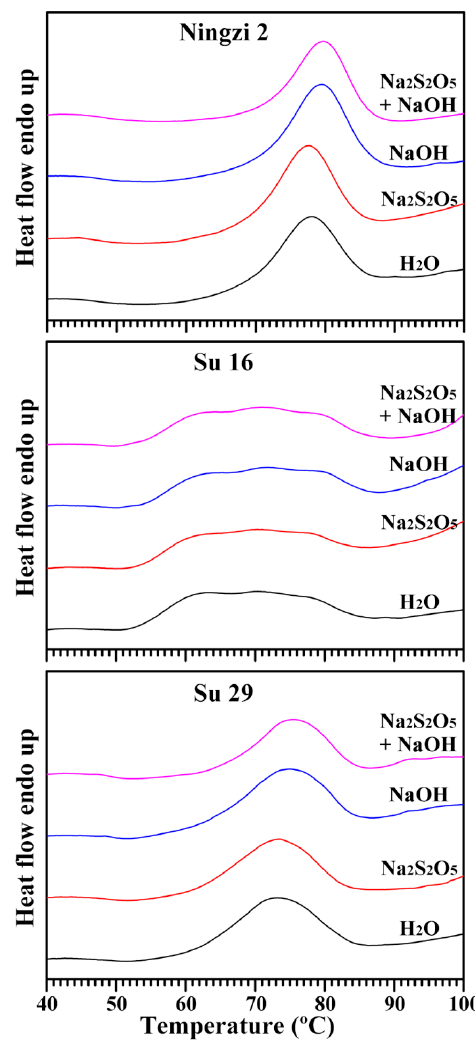
Figure 7. Differential scanning calorimetry thermograms of starches. Table 4. Thermal properties of starches.